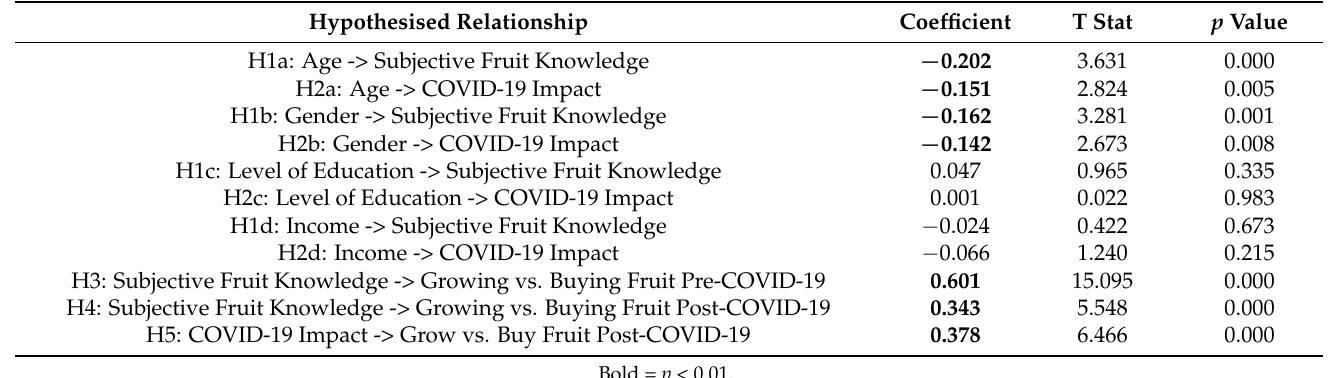
Table 4. Results from Hypothesis Testing.